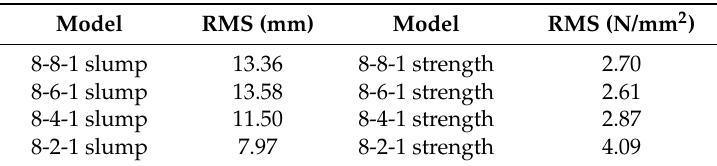
Table 7. ANN model RMS errors for testing dataset.